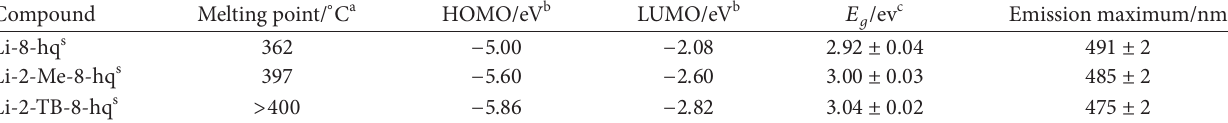
Table 1: Melting points, HOMO-LUMO values, band gaps, and photoluminescence of Li-8-hq, Li-2-Me-8-hq, and Li-2-TB-8-hq. Compound